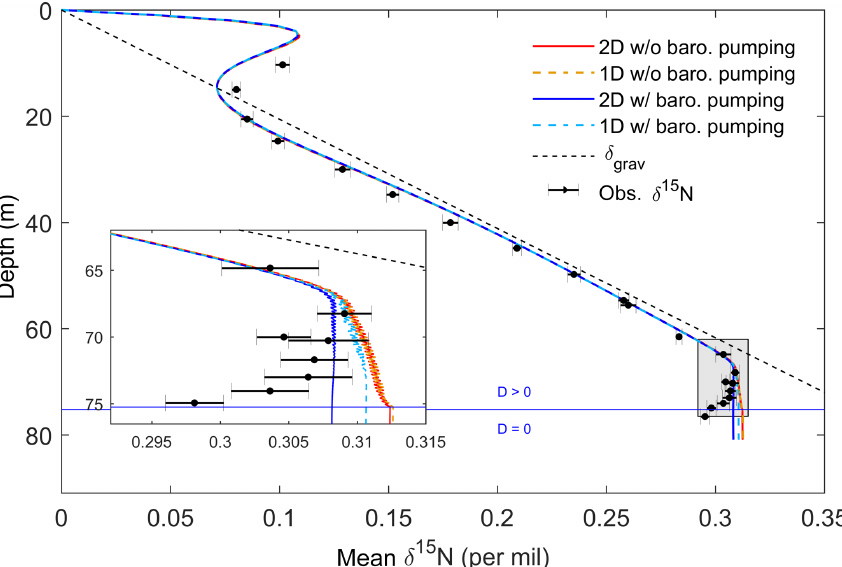
Figure 7. Horizontally averaged δ 15 N at WAIS Divide. Model output is shown from four different versions of the 2-D model (see text). Black circles with error bars indicate the observed firn δ 15 N (Battle et al., 2011). The dashed black line represents the equilibrium solution for pure gravitational settling ( δ grav ). The horizontal blue line marks the depth where vertical diffusivity reaches zero. The inset shows a magnification of the lock-in zone.